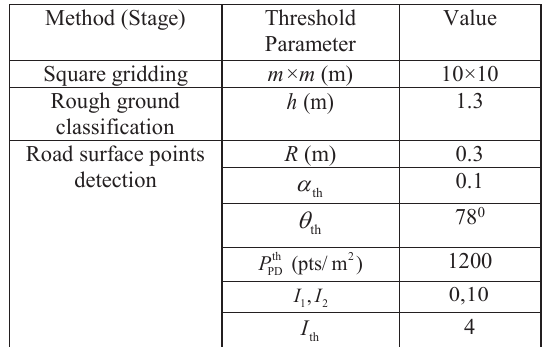
Table 1. Parameters values used for the test site.